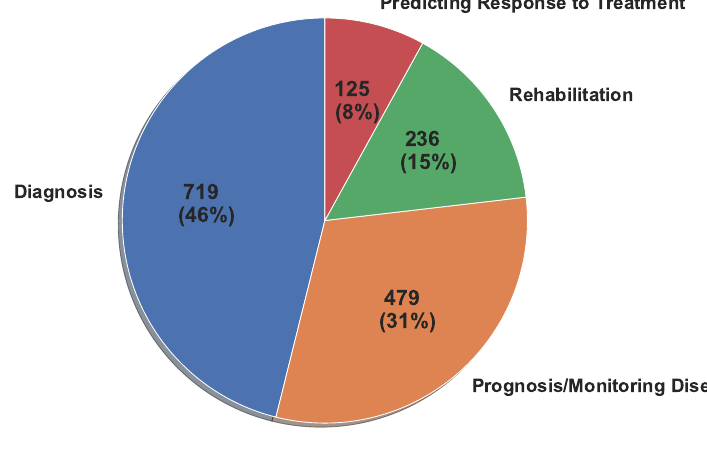
Figure 5. Percentage of publications (2008–2021) by application